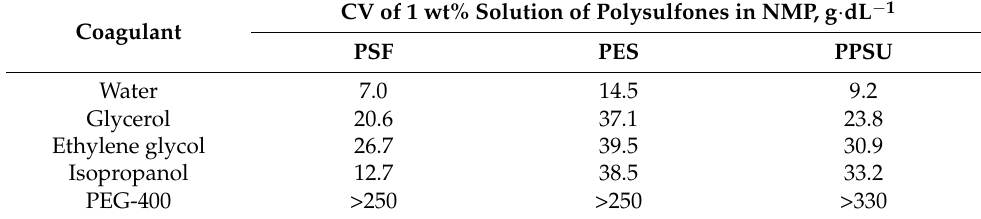
Table 2. Coagulation values (CV) of polysulfone solutions in